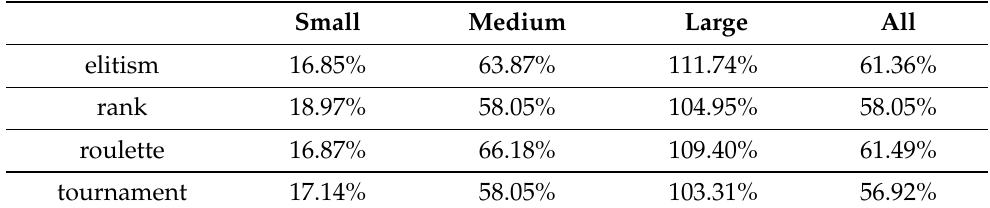
Table 4. All combinations, moderate settings, fast experiment—averaged results for small, medium, large, and all instances, grouped by selection methods.